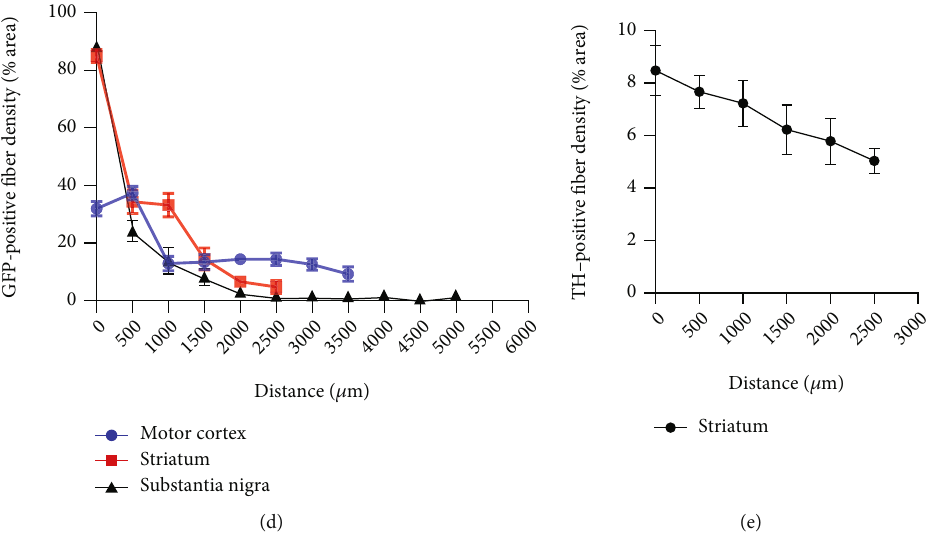
Figure 6: Neurite/axon projection of grafted cells at di ff erent brain regions three months following transplantation. (a) GFP-positive cellular grafts were detected in the motor cortex (A), striatum (B), and substantia nigra (C), as well as the magni fi ed insets at areas away from the graft bolus. Scale bars, 1 mm. (b) Immuno fl uorescence staining of TH. The inset showed the GFP-positive cells that were also positive for TH. Scale bars, 500 μ m. (c) The dotted line represents the area of the graft were measured 3 months following transplantation into the brain of the nonhuman primate. (d) Quanti fi cation of GFP-positive neurite density as to the distance to the graft injection sites at the three brain regions. (e) Quanti fi cation of GFP/TH double-positive neurite density as to the distance to the graft injection site at the